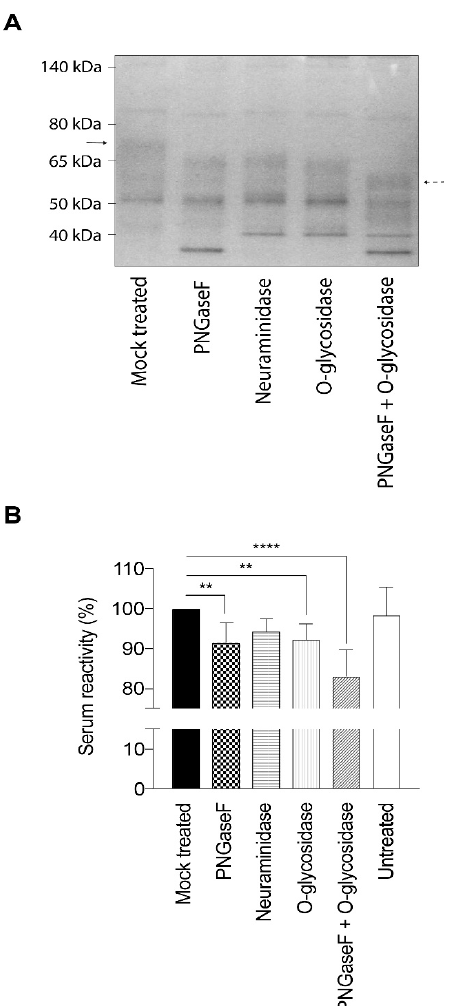
Figure 3. Enzymatic deglycosylation of gE HP reduces the reactivity towards serum from individuals earlier infected with VZV. Glycans were removed by PNGaseF, neuraminidase, and O-glycosidase treatment, respectively. ( A ) Deglycosylation of gE HP was verified by gel electrophoresis and the enzymatic hydrolysis resulted in distinct size shifts. Solid arrow indicates fully glycosylated gE HP and dashed arrow indicates gE HP stripped of both N- and O-linked glycans. ( B ) Serum reactivity towards gE HP , either unmodified or deglycosylated, was assessed by ELISA using serum from VZV+ individuals (n = 10). Statistic calculations were done using one-way ANOVA with Tukey’s multiple comparisons test (significance is indicated by ** p -values < 0.01 and **** p -values < 0.0001).